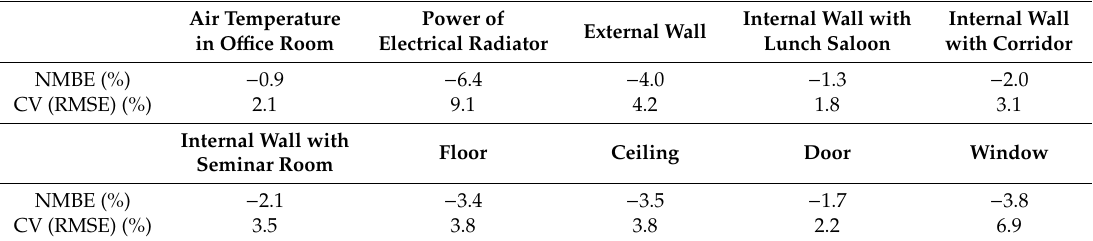
Table 5. The calculated calibration indices for the o ffi ce room’s air temperature and the o ffi ce room’s di ff erent surface temperatures (on an hourly basis) and for the power of the electrical radiator (on a daily